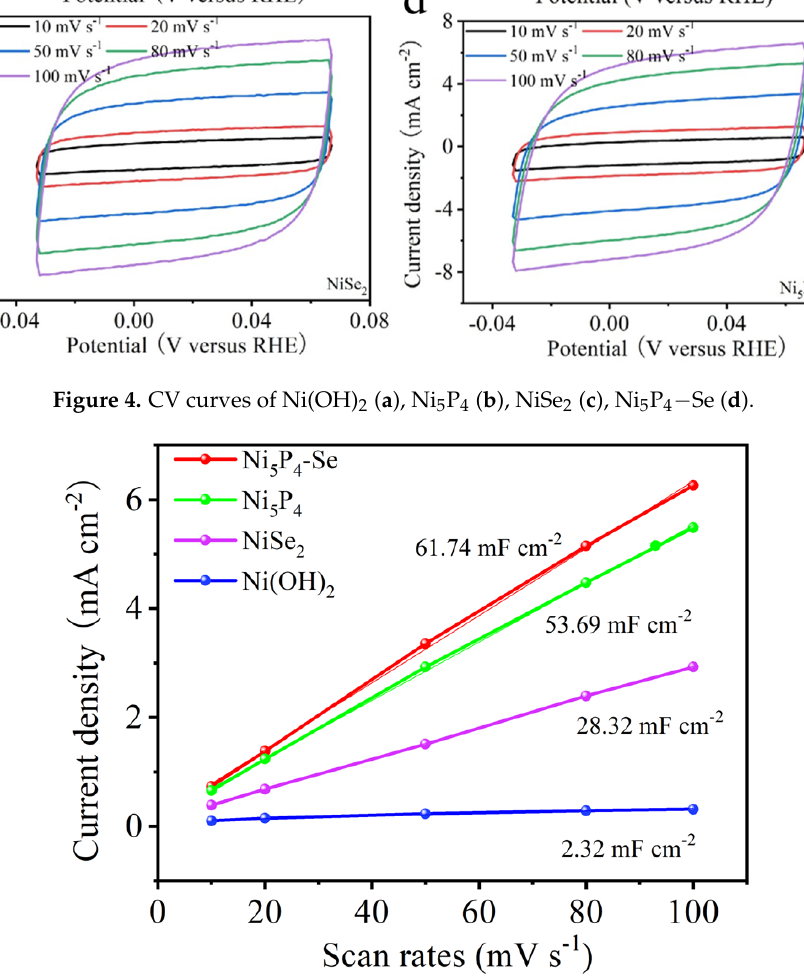
Figure S2: (a–b) SEM images of Ni(OH) 2 precursor; Figure S3: (a–c) SEM images of Ni 5 P 4 ; Figure S4: (a–c) SEM images of NiSe 2 ; Figure S5: High-resolution XPS of Ni 5 P 4 and NiSe 2 , (a) XPS of Ni 2p in pure Ni 5 P 4 , (b) XPS of P 2p in pure Ni 5 P 4 , (c) XPS of Ni 2p in NiSe 2 , (d) XPS of Se 3d in NiSe 2 ; Figure S6: TEM images (a-b) of Ni 5 P 4 -Se composites; Figure S7: Energy spectrum for Ni 5 P 4